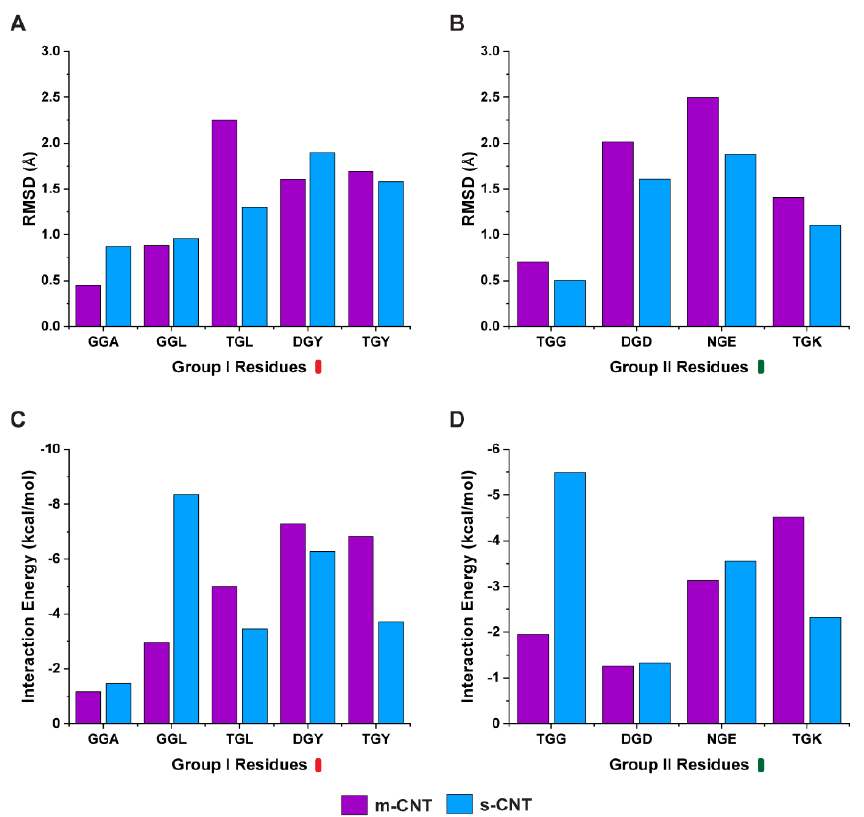
Figure 3. ( A , B ) Change in average RMSD for the sidechains of the flanking residues and the ( C , D ) interaction energy between the sidechains of the flanking residues and the CNTs for Group I and II tripeptide combinations.